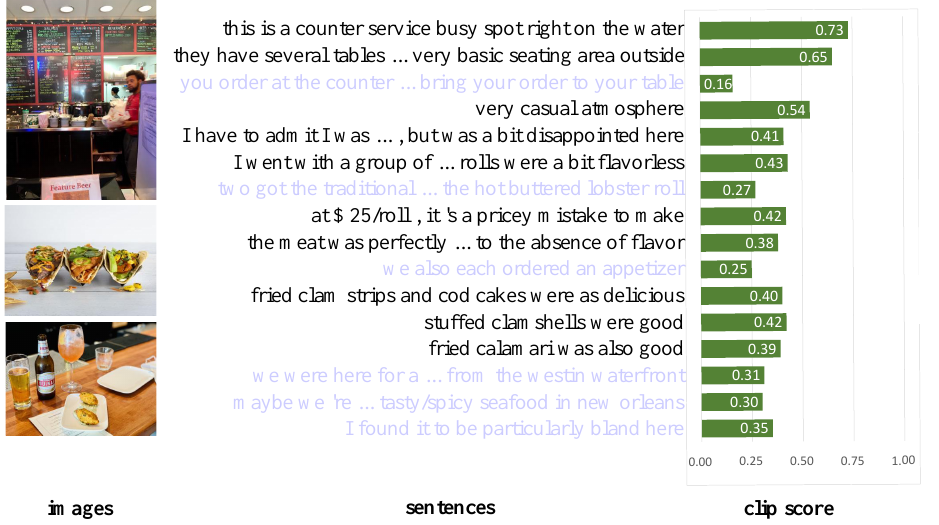
Figure 5. A sample of knowledge distillation based on the CLIP visualization. For the sake of simplicity, here we take an example of M = 10.